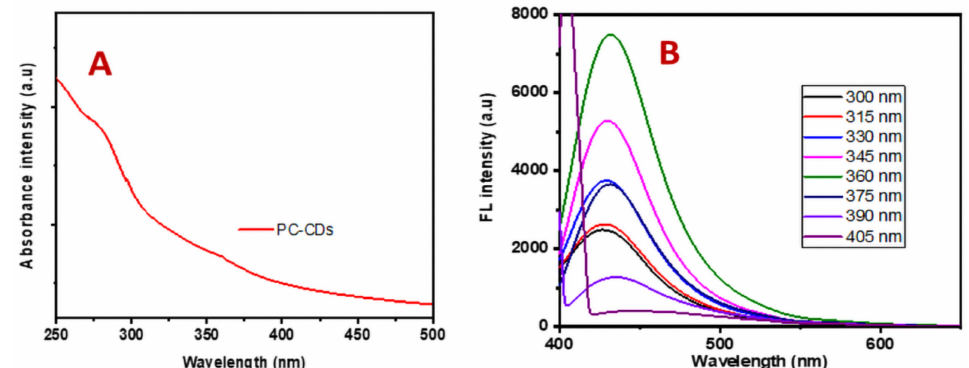
Figure 3. ( A ) UV–Vis absorption spectra of synthesized PC-CD solution, and ( B ) FL emission spectra of the PC-CDs as a function of different wavelength excitations.